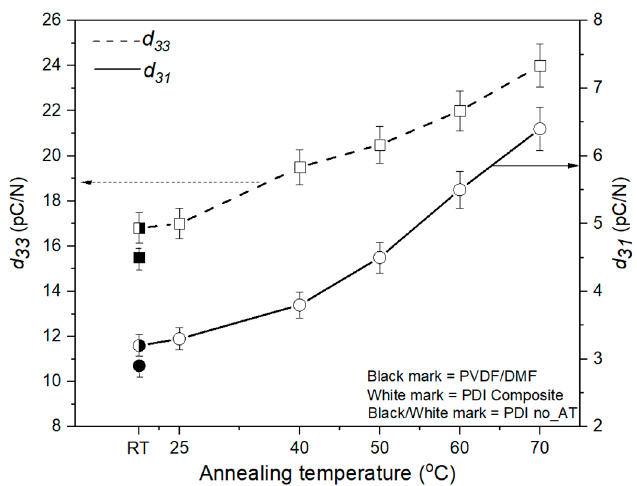
Figure 10. Piezoelectric coefficient d 33 and d 31 for different annealing water temperature.